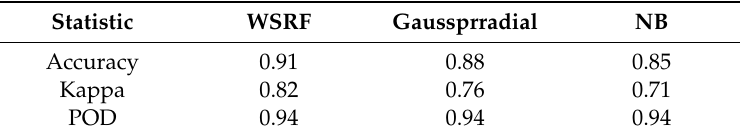
Table 3. The performances of the models using the testing